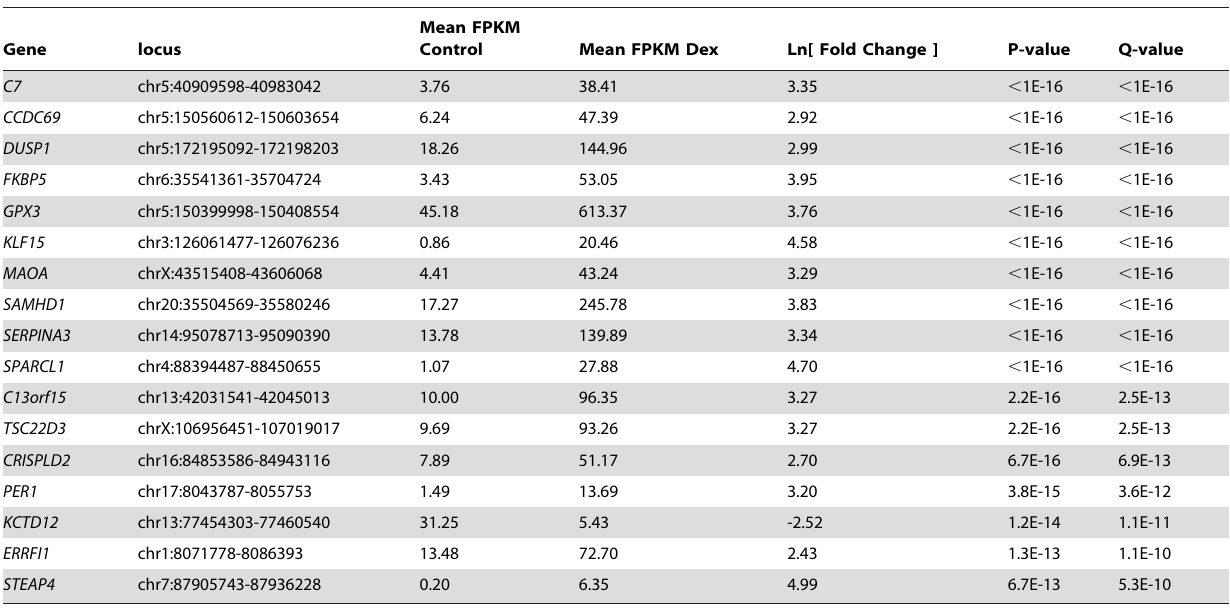
Table 1. Top (Q-value , 1E-10) differentially expressed genes.